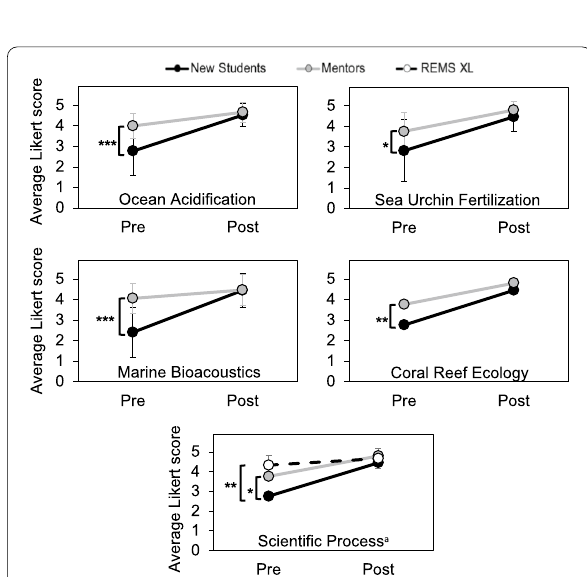
Fig. 10 Competence: Comparing science knowledge competence scores among student groups. Average Likert scores (1 Not at all, = 5 A great deal) on REMS survey items collected from New Students = ( N 54) and Mentors ( N 18) in the 2016–2018 REMS programs, = = and REMS XL students ( N 12). Differences among student groups Not at all, 5 A great deal) = compared with Mann–Whitney tests for two groups, and Kruskal– = = 54) in Wallis with post hoc Dunn’s tests for three groups. a The survey = for REMS XL students only included this item. * p < 0.05. ** p < 0.01. *** p <